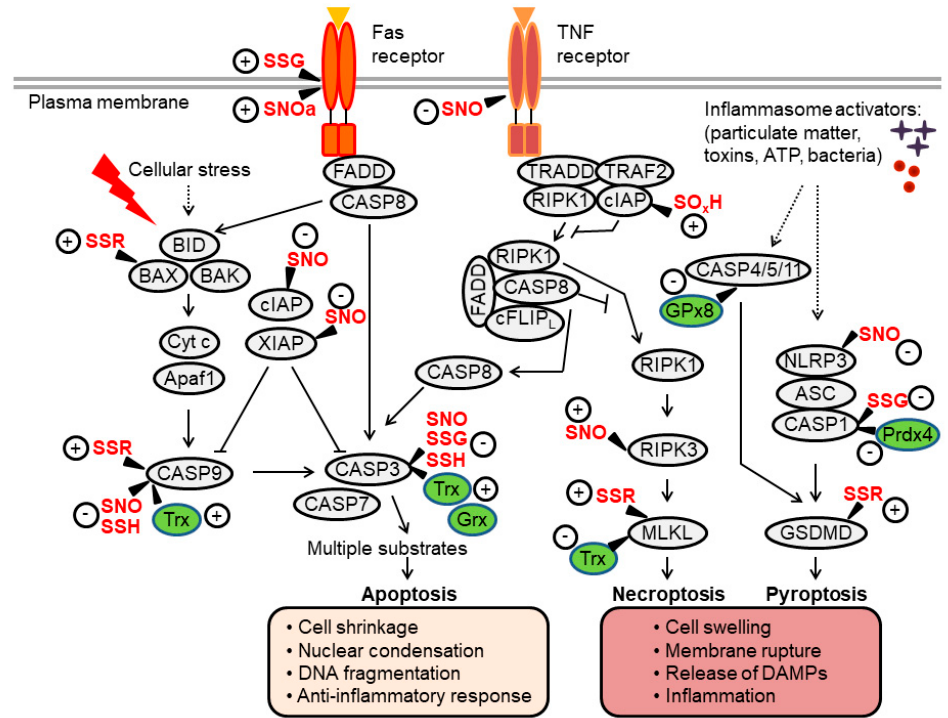
Figure 2. Overview of apoptosis, necroptosis and pyroptosis pathways and their regulation by thiol redox modifications. Extrinsic apoptosis is mediated by the Fas-associated death domain (FADD)-caspase-8 axis, which activates executioner caspases (caspase-3, -7). Intrinsic apoptosis involves mitochondrial outer membrane permeabilization, a process regulated by B-cell lymphoma (BCL)-2-family proteins (such as BID, BAX and BAK). This leads to the formation of the apoptosome (a complex of cytochrome c (Cyt c) and apoptotic protease-activating factor-1 (Apaf-1), which facilitates activation of caspase-9 upstream of caspase-3 / 7. Activation of the tumor necrosis factor (TNF) receptor can induce apoptosis through a signaling cascade that activates caspase-8. Under conditions of caspase-8 inhibition, a protein complex consisting of receptor-interacting kinase (RIPK)1 / 3 and mixed lineage kinase-like (MLKL) is formed, promoting the execution of necroptotic cell death. In inflammatory cells such as macrophages, pathogens and danger signals promote the assembly of inflammasome complexes, which activate caspase-1 or, in some settings, mouse caspase-11 (human caspase-4 / -5). These inflammatory caspases cleave gasdermin D (GSDMD) to induce pyroptosis. Proteins directly regulated by thiol modifications or redox enzymes (thioredoxin [Trx], glutaredoxin [Grx], glutathione peroxidase [GPx]) are highlighted, where “ + ” and “-“ indicate positive and negative e ff ects on protein activity, respectively (see the main text for further details). Through these thiol redox switches, oxidants and Trx / GSH systems influence regulated cell death (RCD) processes and the crosstalk between them. SNO, nitrosylation; SOH, sulfenylation; SSG, glutathionylation; SSR, disulfide formation; SO x H, oxidation or